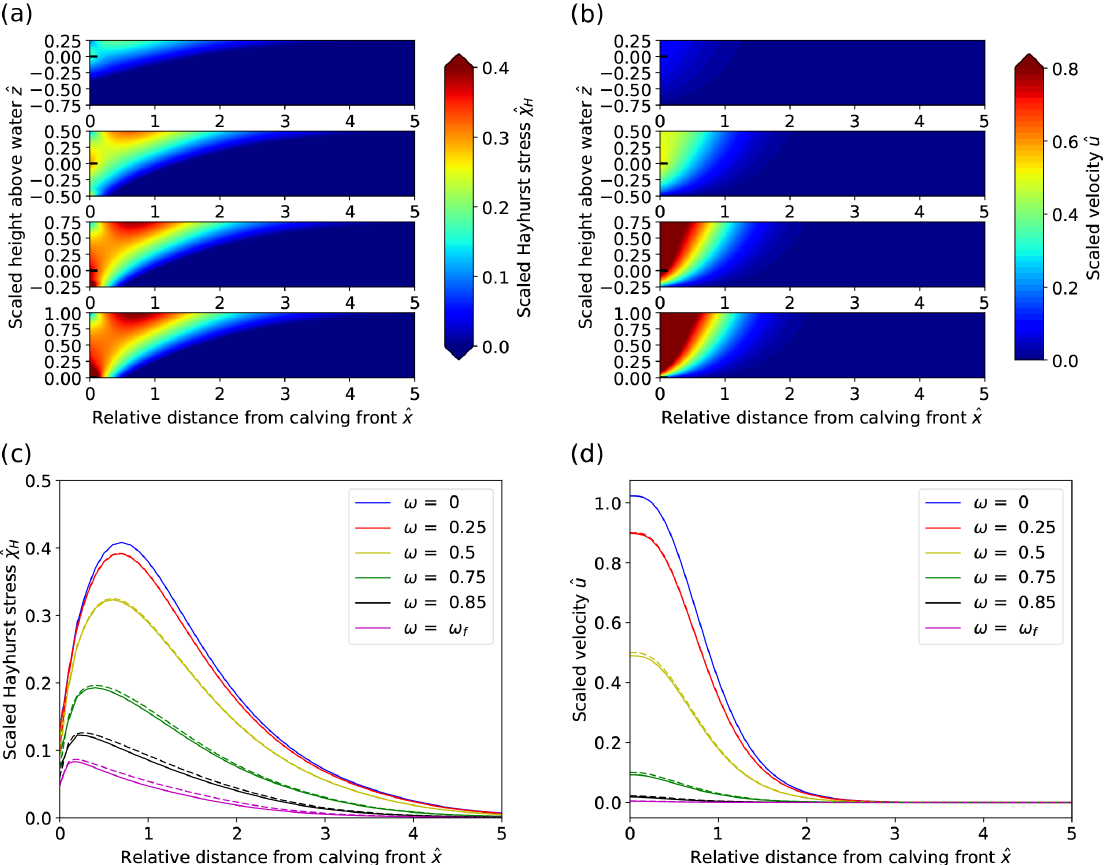
Figure 3. Sensitivity experiment results for varying water depth. (a) Scaled Hayhurst stress distribution. (b) Scaled horizontal velocity distributions. (c) Scaled Hayhurst stress along the surface. (d) Scaled horizontal velocity magnitude along the surface. In panels (a, b) , the subplots show increasing water depth from the bottom to the top (water level at b z = 0). Solid and dashed lines in panels (c, d) correspond to experiments with sea- and freshwater densities, respectively.